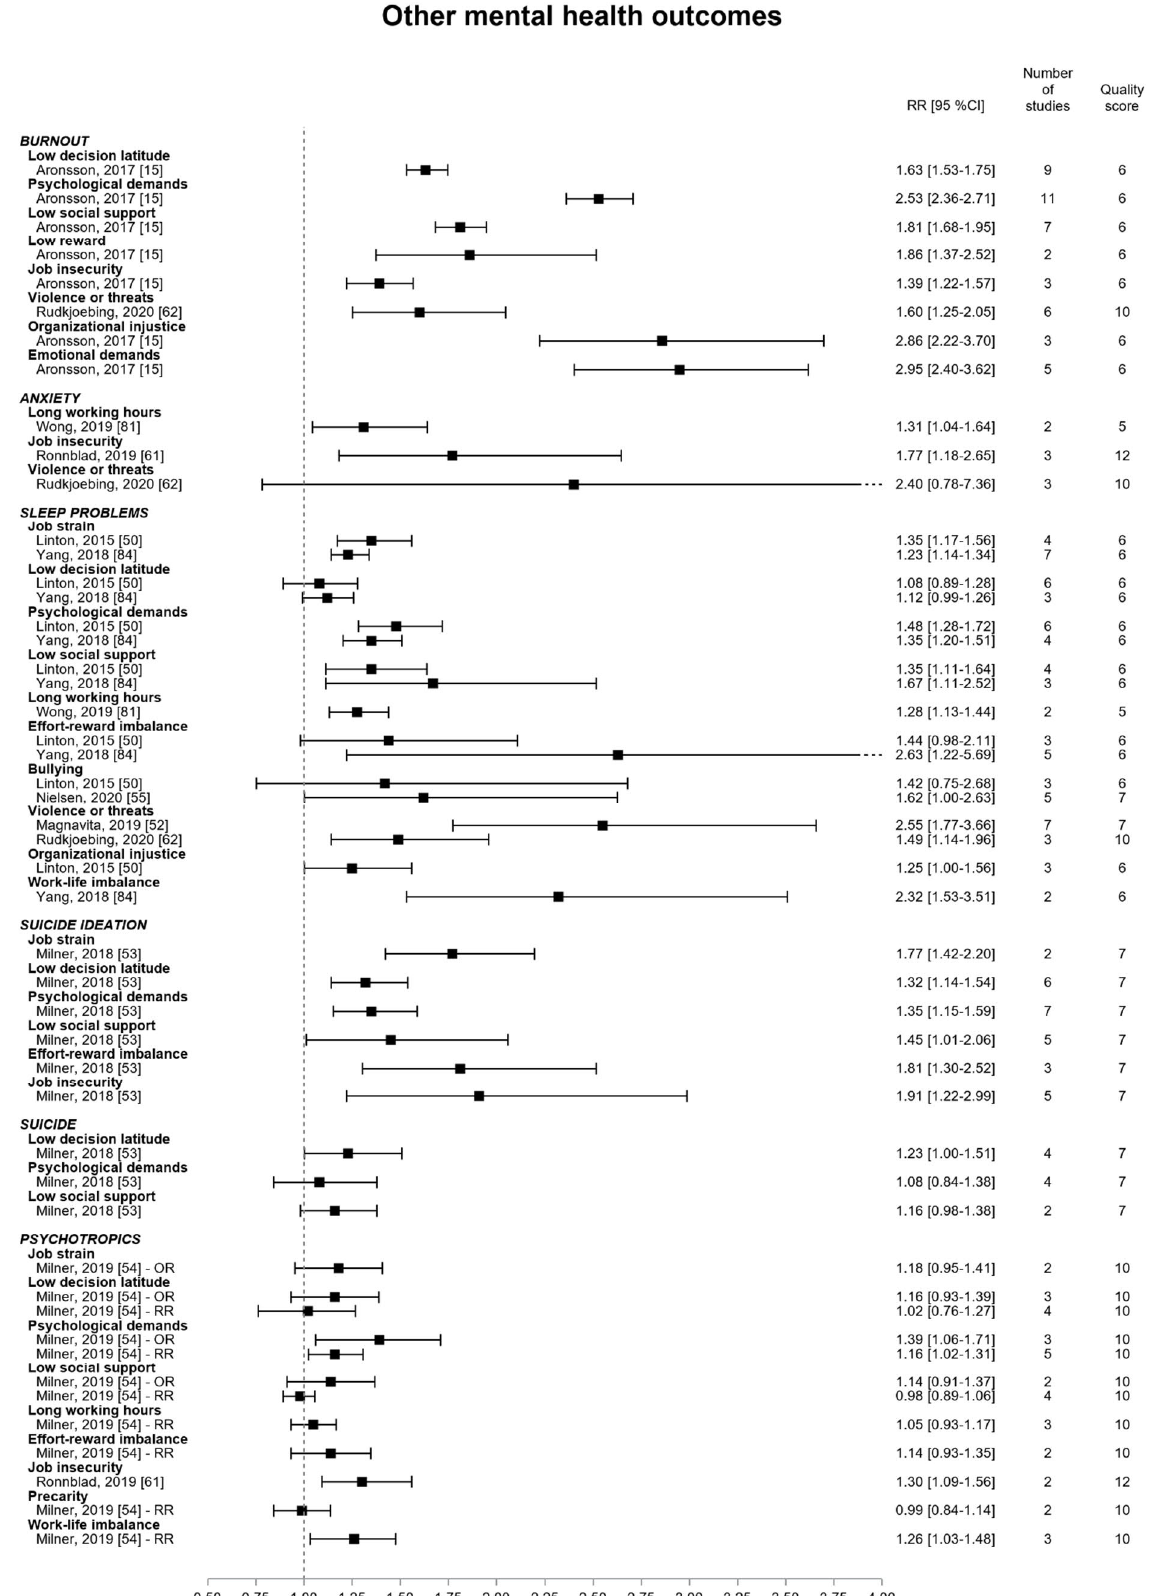
Figure 8. Pooled estimates for the associations between psychosocial work exposures and other mental health